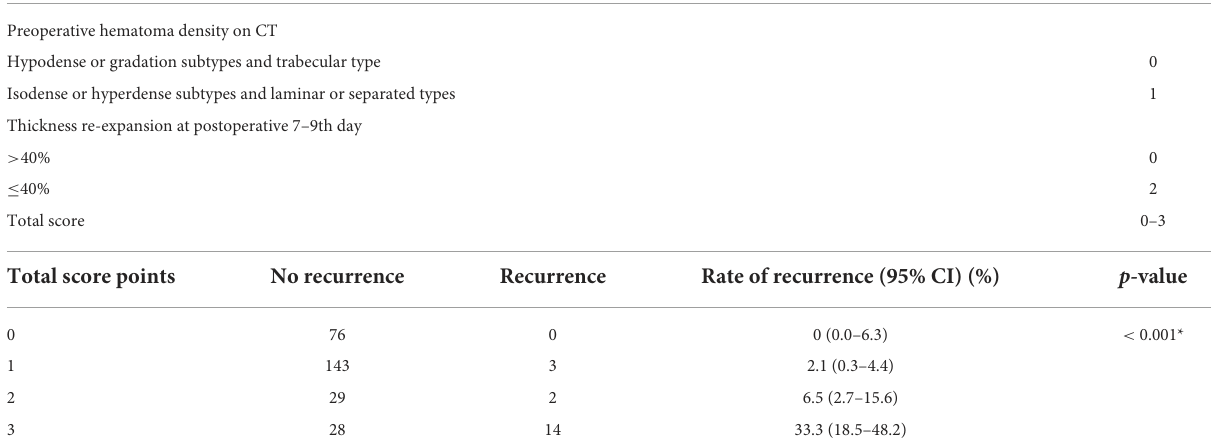
TABLE 5 Changchun CSDH grading system for prediction of RrR ( n = 295). Components of the grading system (Unilateral)